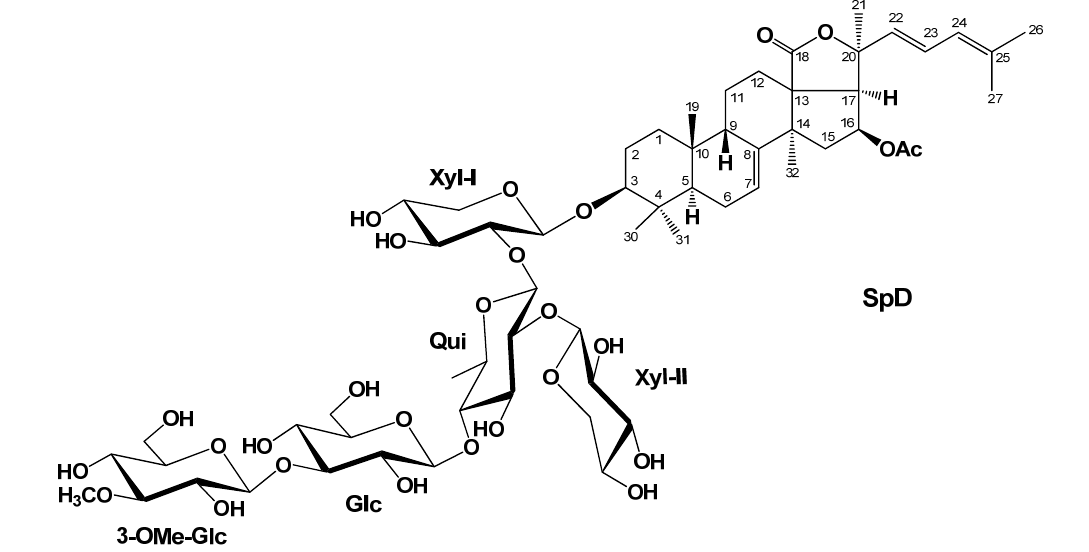
Figure 1. The structure of pacificusoside D (SpD) from the starfish S. pacificus .